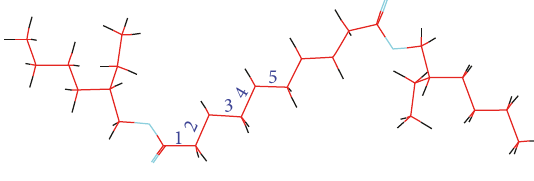
Figure 2: Optimized structure of DIOS.